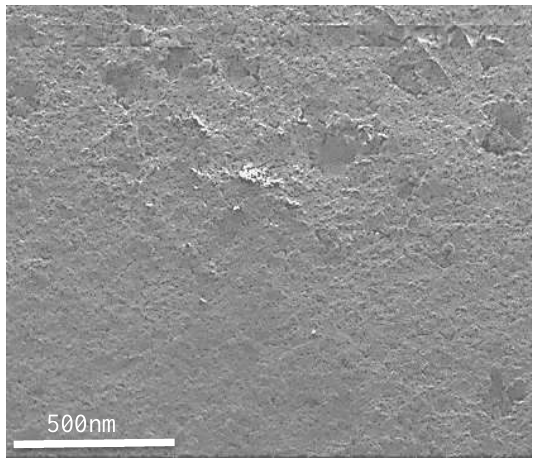
Figure 8: The SEM micrograph in the presence of the corrosion inhibitor for mild steel (ABCP).